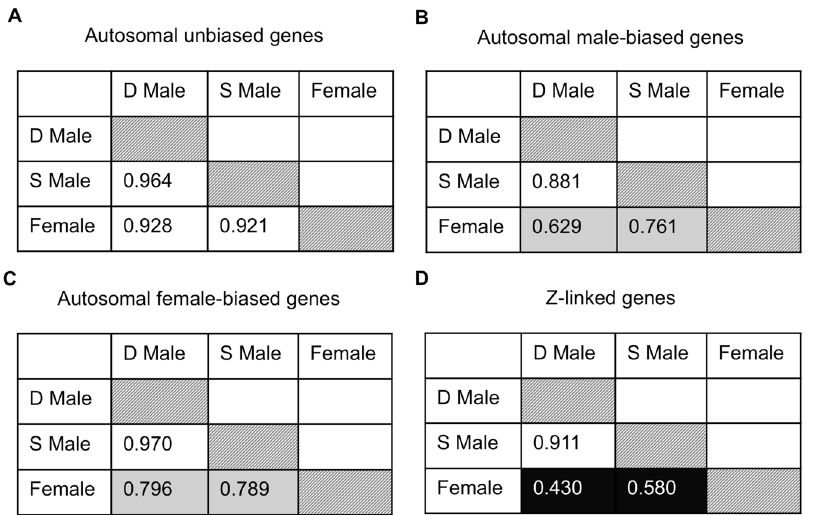
Figure 4. Expression similarity across sexual forms. Spearman rank order ( r ) correlations for average expression for females, subordinate males and dominant males for autosomal unbiased (panel A), autosomal male-biased (panel B), autosomal female-biased (panel C), and Z-linked (panel D) genes. Correlation values are colour coded with lighter colours indicating greater correlation.